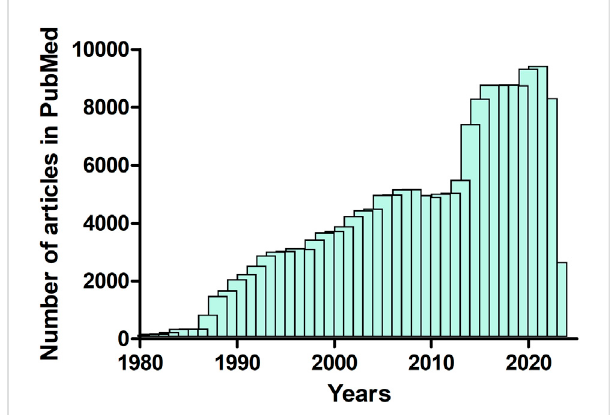
FIGURE 1 Number of articles (review and research articles) published between 1980 and April 2023 that contain the term “ protein biophysics ” (data from PubMed,